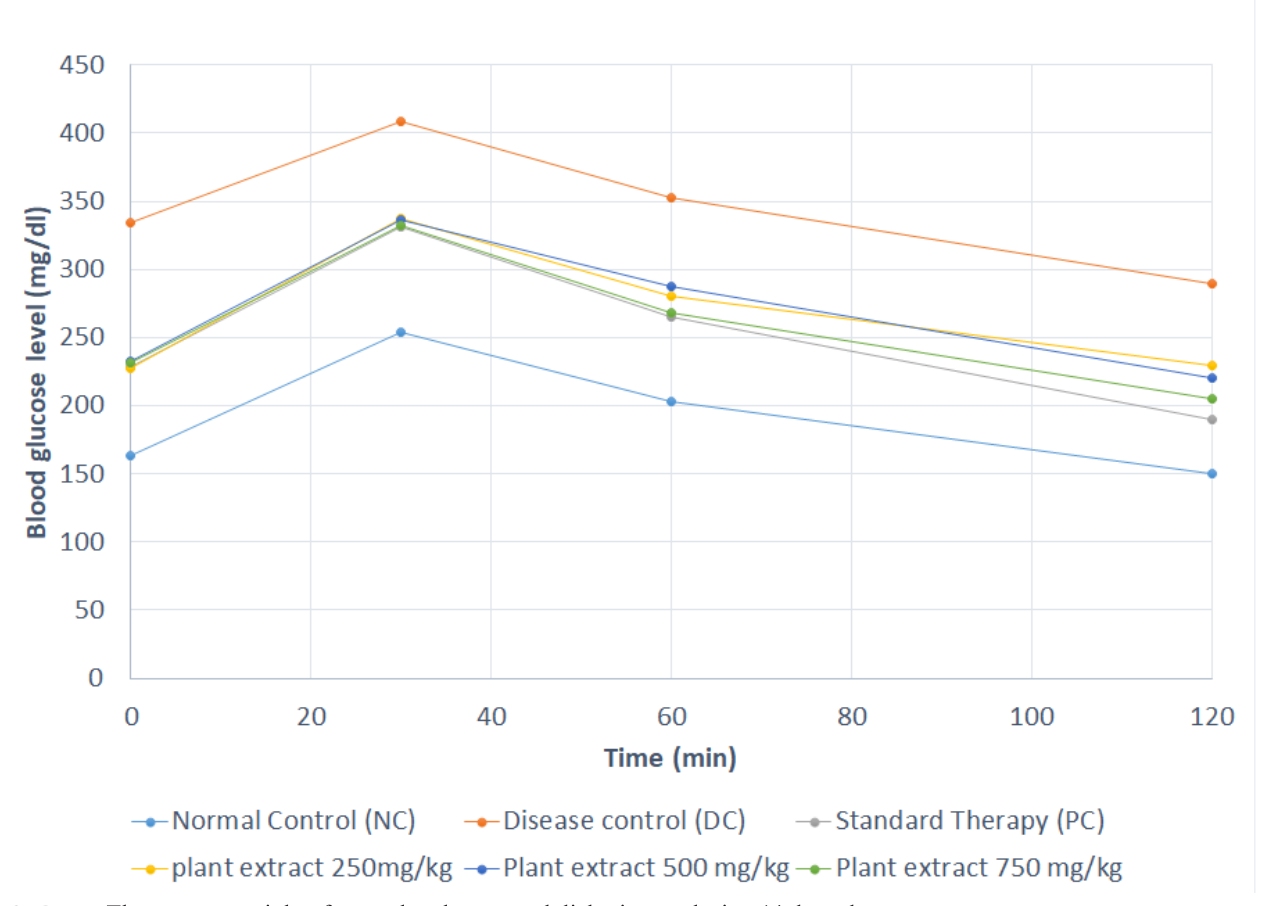
FIGURE 2 – The average weight of treated and untreated diabetic rats during 14 days therapy. Where * showed significantly different at p<0.05 as compared to untreated disease